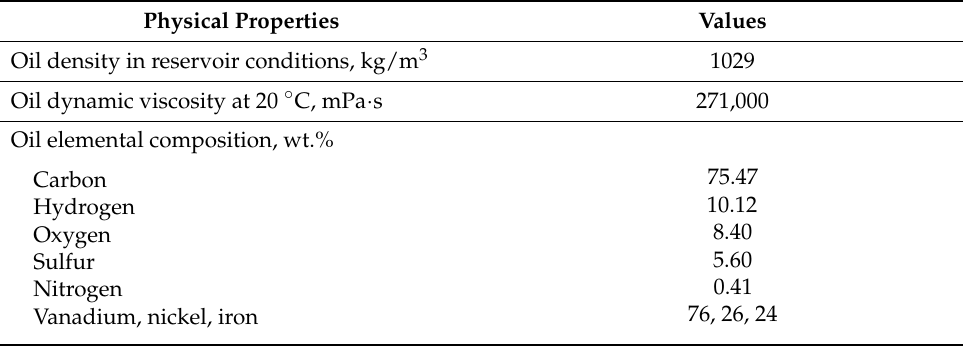
Table 1. Physical properties of Boca de Jaruco extra-heavy